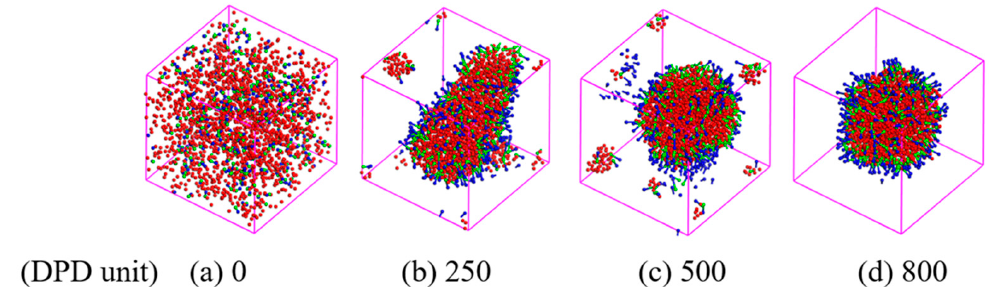
Figure 3. Snapshots of the evolution of the W/O microemulsion structure in DPD simulations with oil/water = 1/3. The hydrophilic group of surfactants are shown in green; the hydrophobic group is shown in blue. The water beads is shown in red. To clarity observe the internal structure, oil beads (pink) are not displayed.